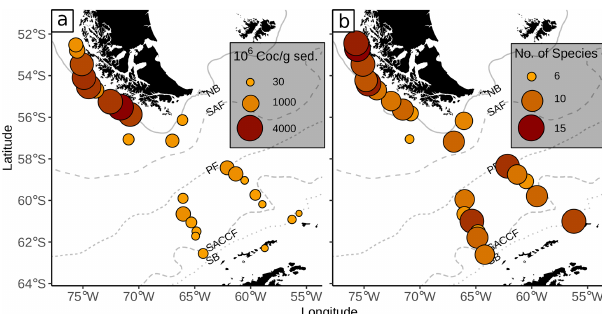
Figure 3. (a) Total number of coccolith as well as (b) number of coccolith species in the studied surface sediments of the DP. Data from stations PS97/071-2, 077-1 and 079-1 are only shown in (a) . ACC fronts from north to south: NB (Northern Boundary), SAF (Subantarctic Front), PF (Polar Front), SACCF (Southern ACC Front) and SB (Southern